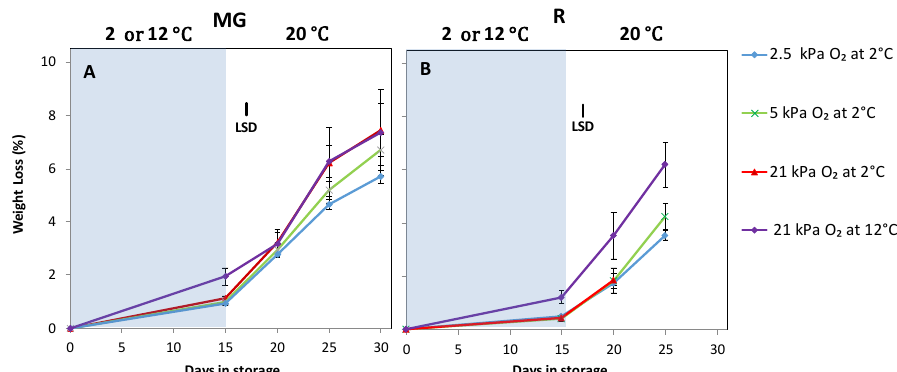
Figure 2. Weight loss of MG ( A ) and R ( B ) tomatoes during cold storage at 2 or 12 ◦ C (blue area) and subsequent shelf-life at 20 ◦ C (white area). Blue, green, red and purple lines and symbols indicate 2.5, 5, 21 kPa O 2 (low oxygen control) applied during storage at 2 ◦ C and 21 kPa O 2 at 12 ◦ C (temperature control), respectively. The average weight loss with indicated standard error is shown for five tomatoes. LSD values ( p < 0.05) are indicated per panel.